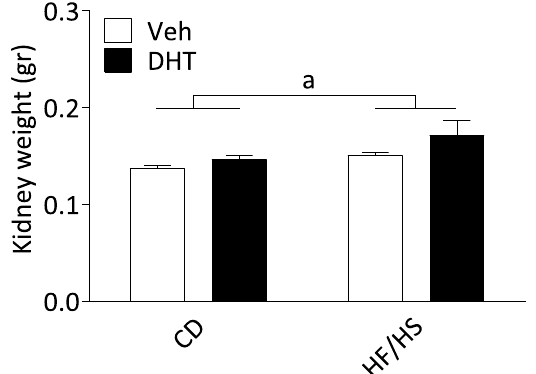
Figure 5. Kidney weight. The weight of the kidneys. a = Main effect of diet; p < 0.05 vs CD. Values are means ± SEM.